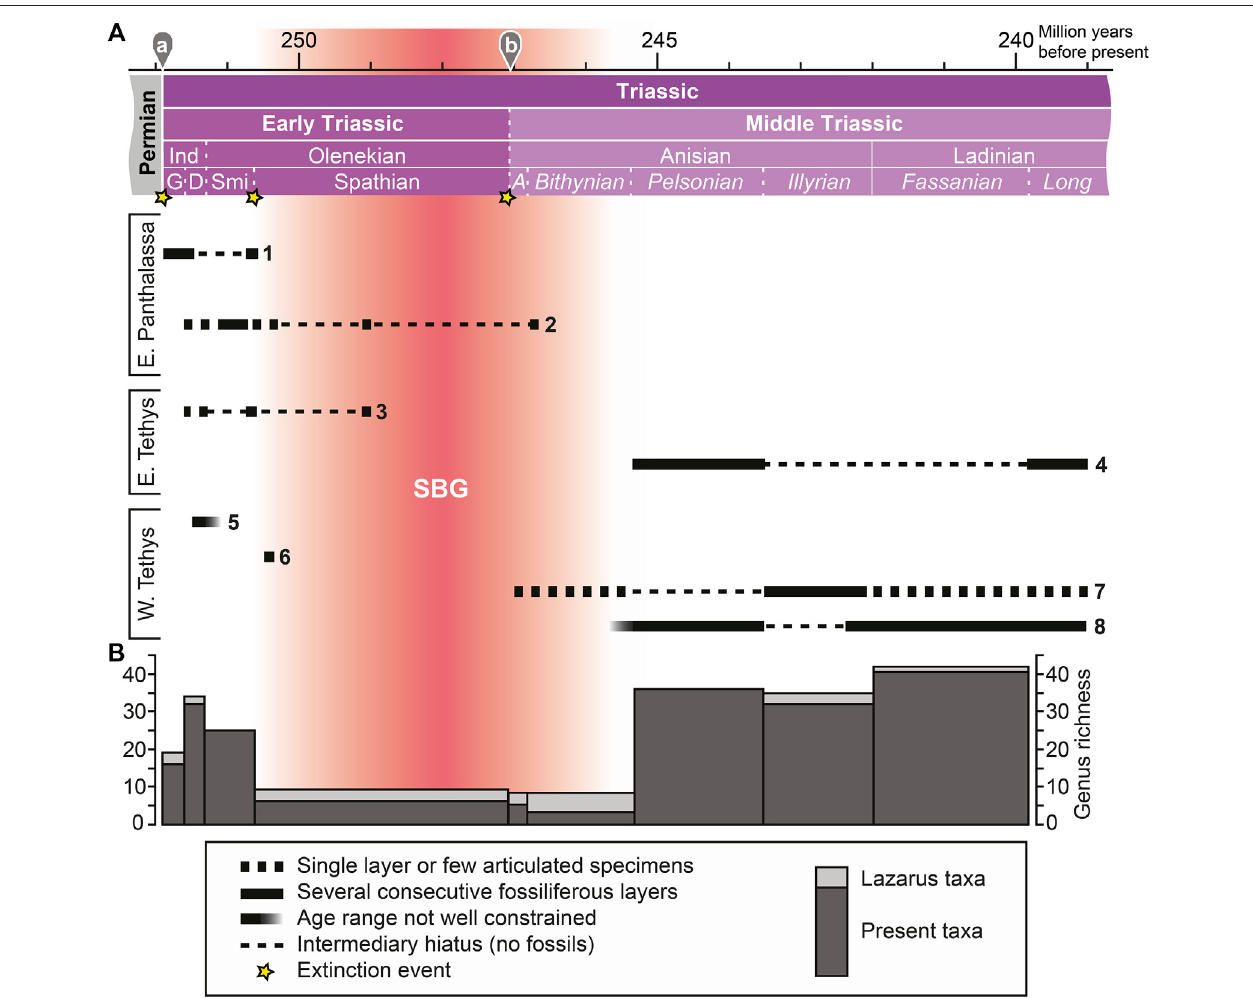
FIGURE 1 | (A) Stratigraphic ranges of beds preserving bony fi sh fossils across the Spathian-Bithynian Gap (SBG), with localities grouped paleogeographically (East and West Tethys, East Panthalassa). 1. Arctic: Canada (Ellesmere Island, Nunavut), Greenland, Spitsbergen; 2. Western North America: Canada (Alberta, British Columbia), United States (Idaho, Nevada); 3. Eastern China (Anhui, Jiangsu, and Zhejiang provinces); 4. South China (Guizhou and Guangxi provinces); 5. India (Himachal Pradesh) and Madagascar; 6. Romania; 7. Buntsandstein and Muschelkalk (includes brackish taxa): France, Germany, Poland, The Netherlands; 8. SouthernAlps:Italy,Slovenia,Switzerland.Absoluteages:a,Bareseletal.,2017;b,Ovtcharovaetal.,2015.Abbreviatedstratigraphicintervals:A,Aegean;D,Dienerian; G, Griesbachian; Ind, Induan; Long, Longobardian; Smi, Smithian. (B) Stacked diversity of present taxa and Lazarus taxa per time interval (number of bony fi sh genera).